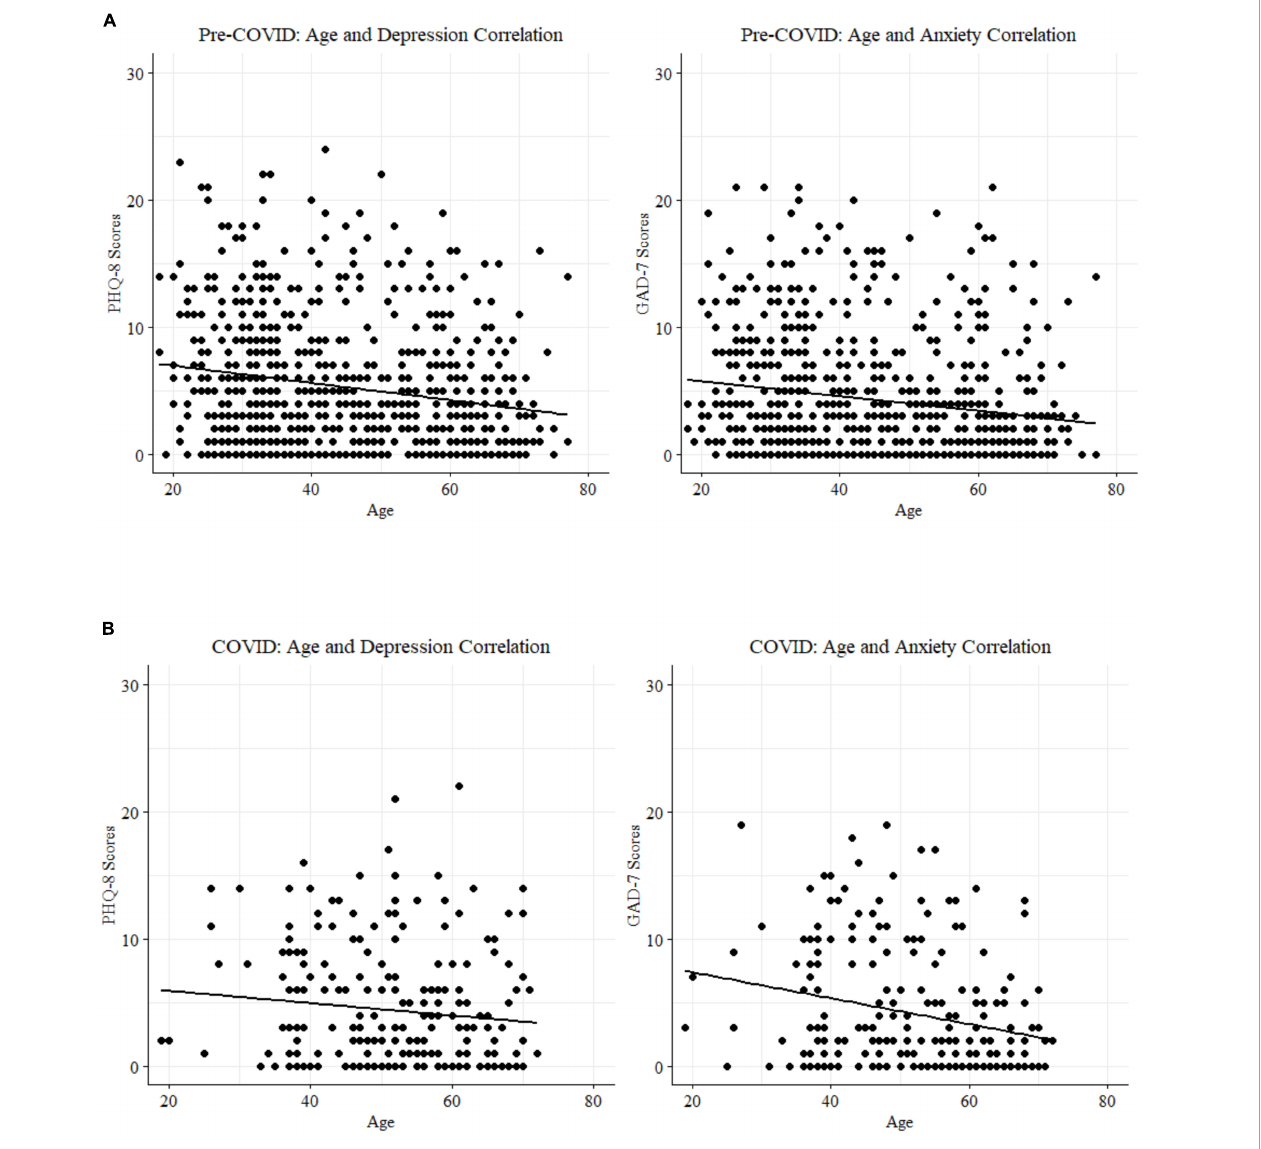
FIGURE4 (A) Age and mood score correlations for the pre-COVID 2018 cohort. (B) Age and mood score correlations for the peri-COVID 2020